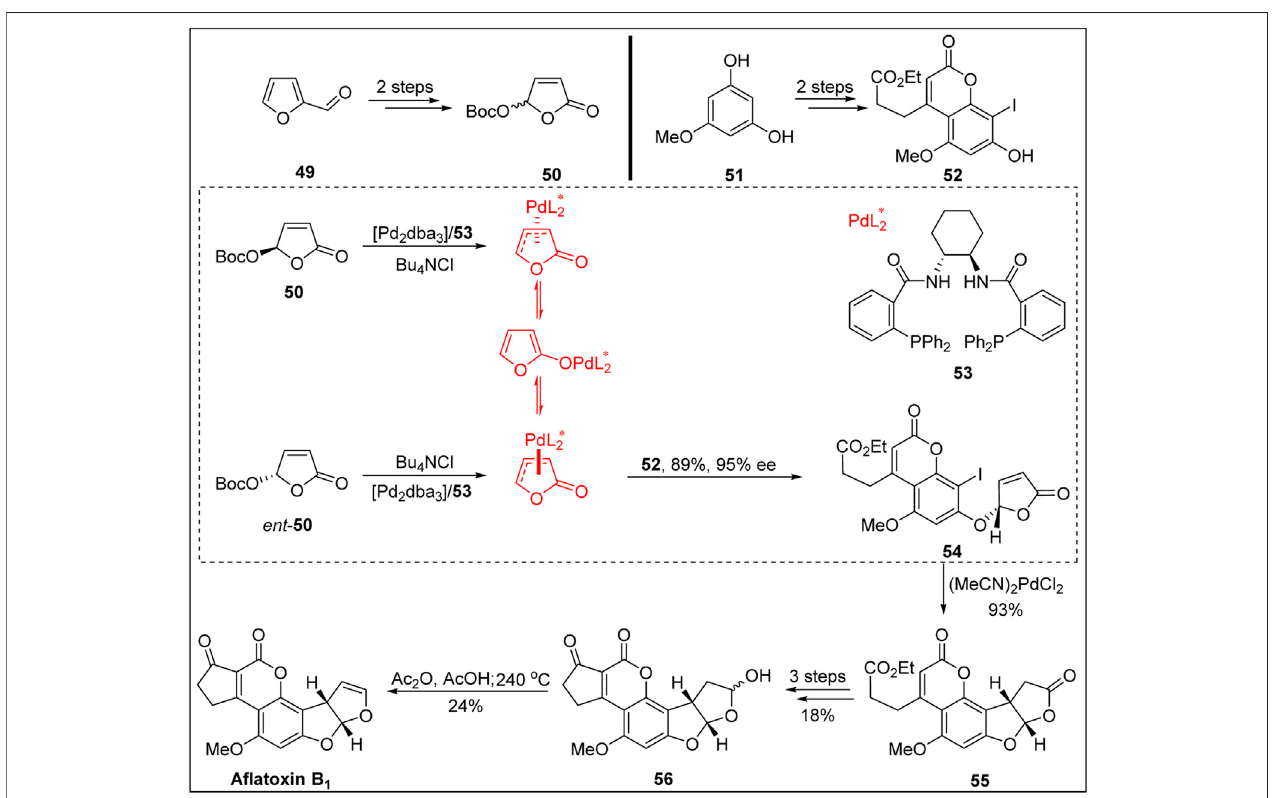
FIGURE 6 | First asymmetric total synthesis of a fl atoxin B